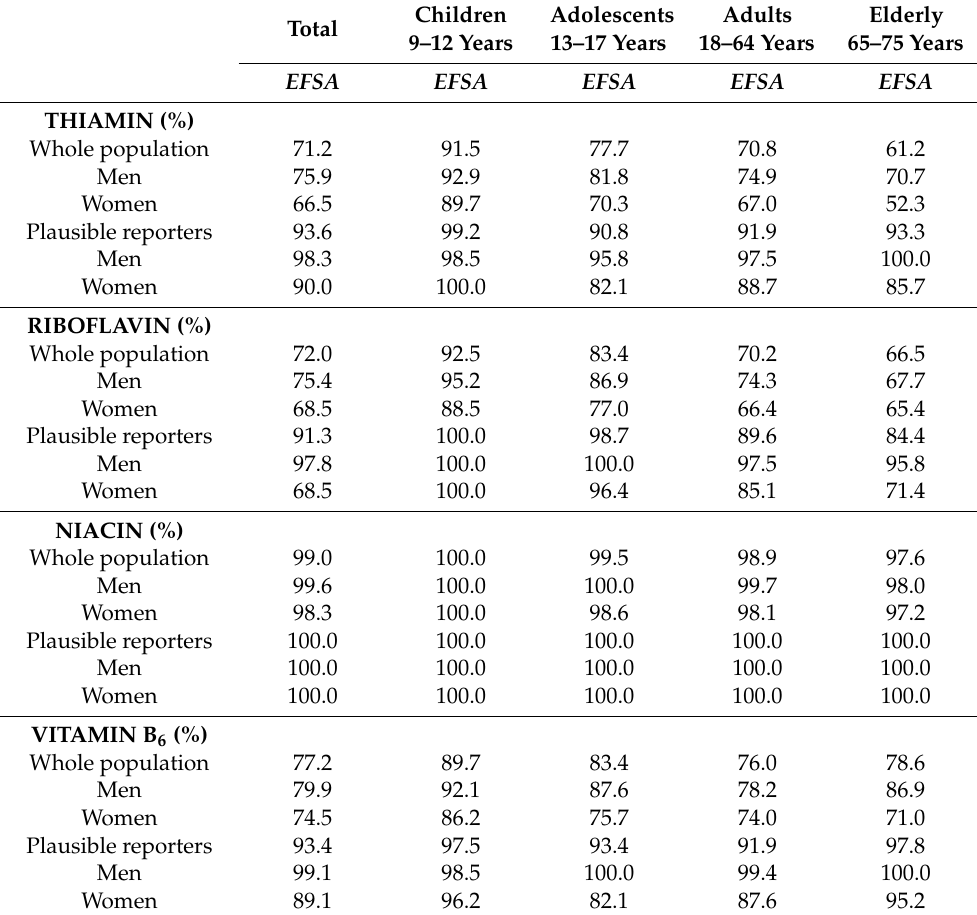
Table 4. Percentage of the population with adequate intake of thiamin, riboflavin, niacin, and vitamin B 6 , for the whole population and for the plausible energy reporters by age